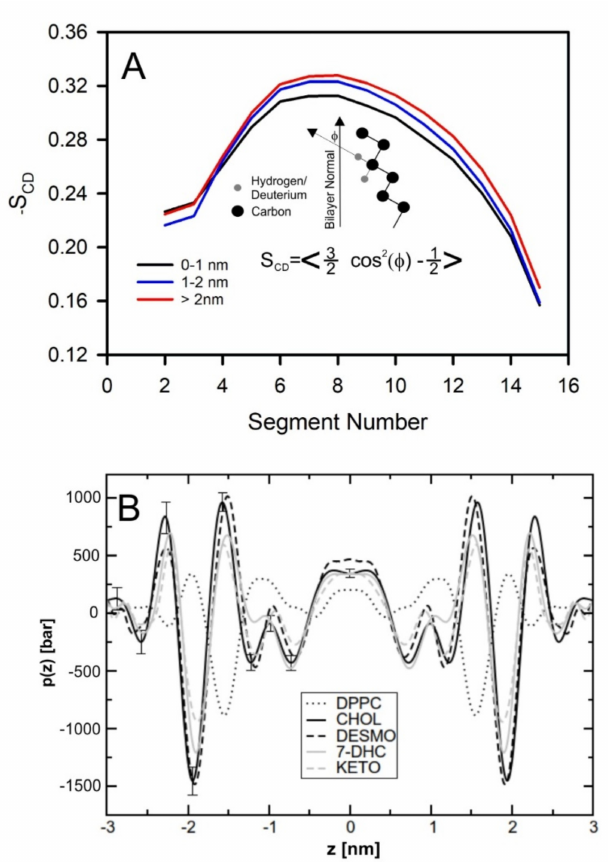
Figure 14. ( A ) Profile of the order parameter S CD for lipids located in three zones: distances 0–1, 1–2, >2 nm from a drug molecule (reproduced with permission from ref. [187]). ( B ) Profile of the lateral pressure in bilayers composed of DPPC, DPPC and cholesterol and DPPC and other steroids (reproduced with permission from ref.